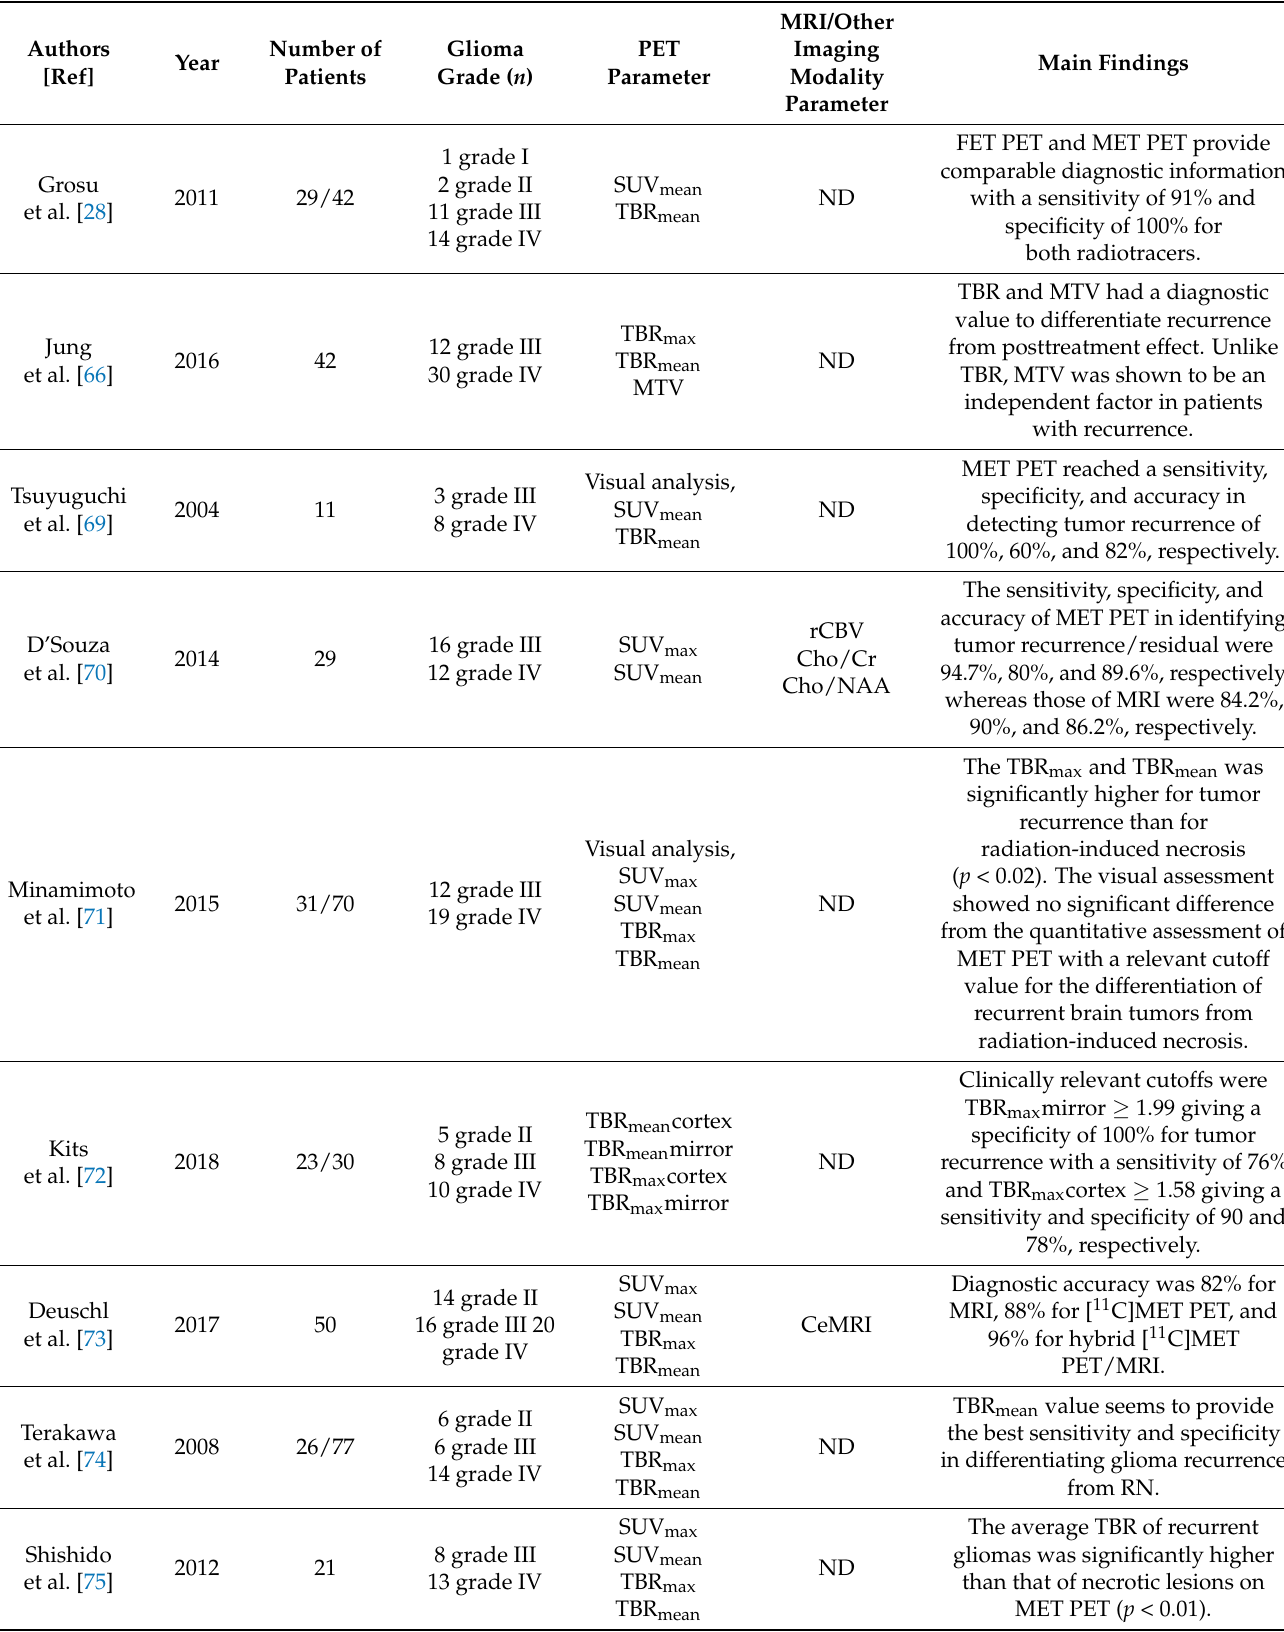
Table 3. Summary of the described studies regarding [ 11 C]MET PET in glioma recurrence/differential